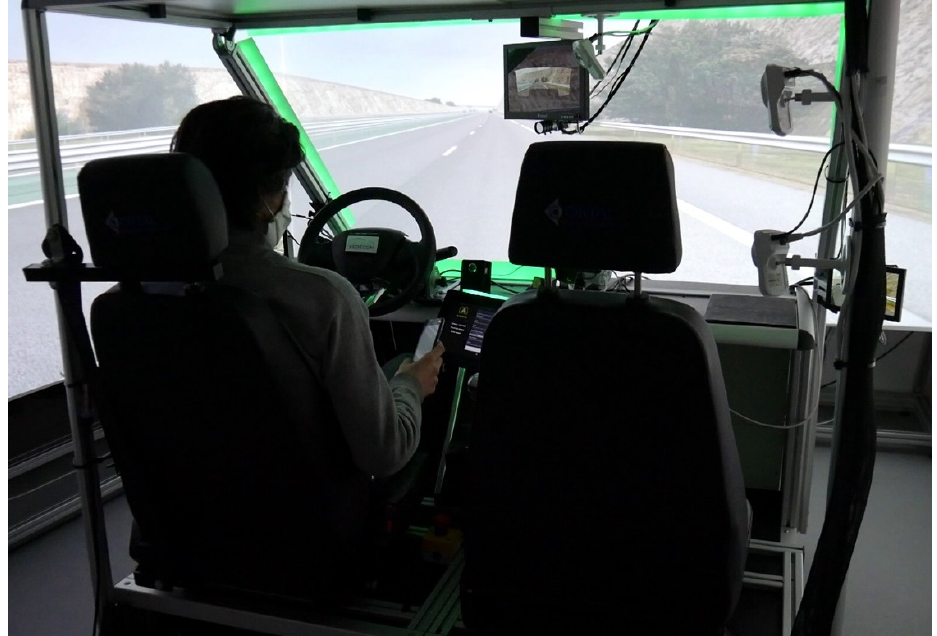
Figure 2. Wide view of the apparatus (the LED stripe is green).